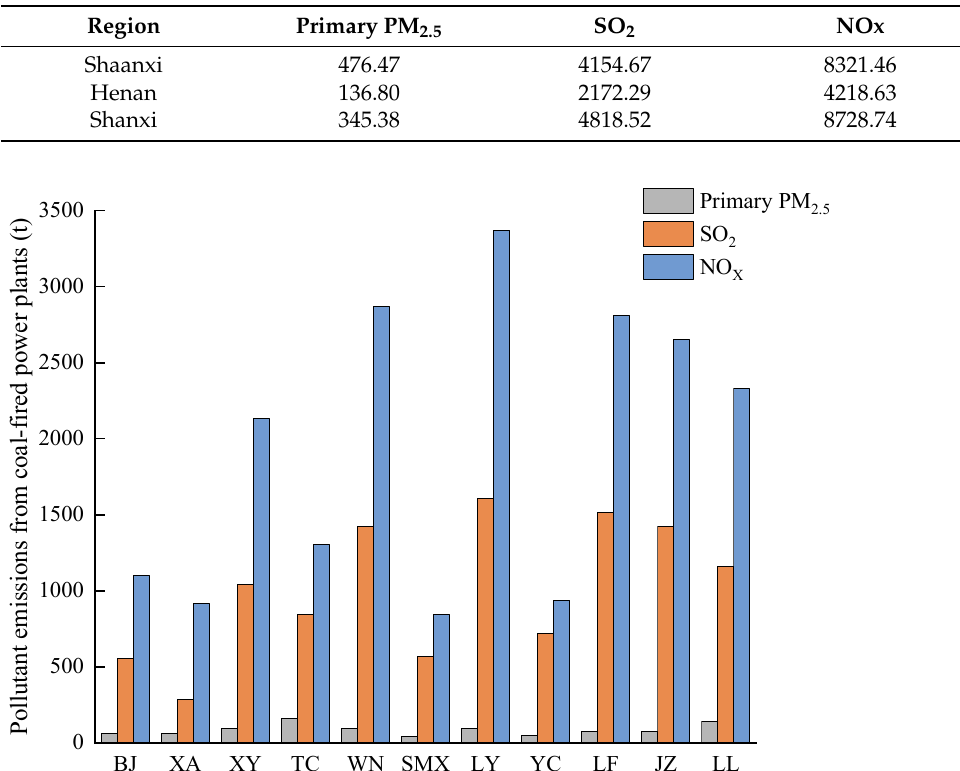
Table 1. Primary PM 2.5 , SO 2 , and NO X emissions in each region of the FWP in 2019 (t).